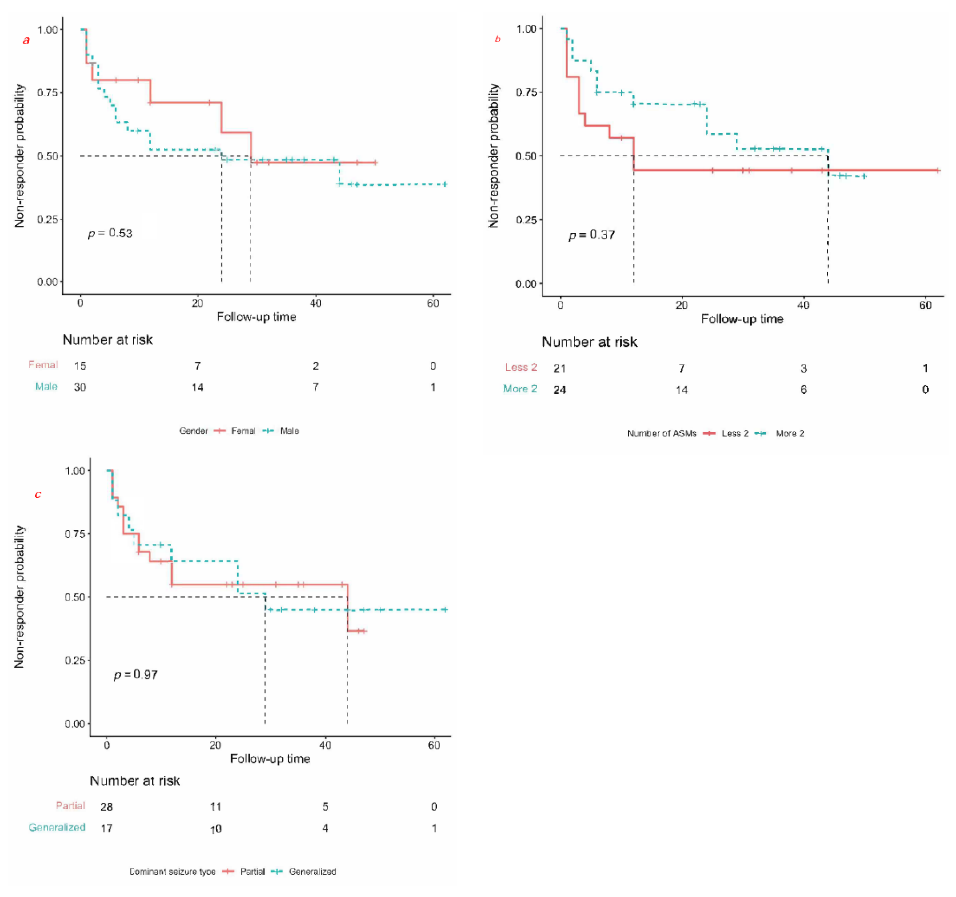
Figure 2. Kaplan–Meier curves for prognostic factors. Survival curve of gender ( a ). Survival curve of number of ASMs ( b ). Survival curve of dominant seizure type ( c ). Table 4. Responders according to etiology.